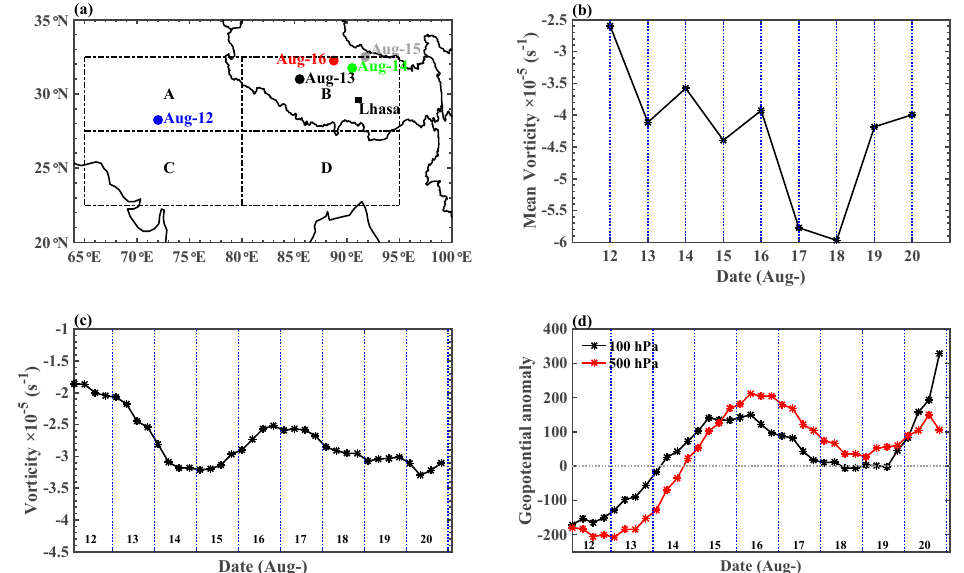
Figure 3. ( a ) The geographic locations of the ASMA centers from 12–16 August 2018. A-area (27.5–32.5 ◦ N, 65–80 ◦ E), B-area (27.5–32.5 ◦ N, 80–95 ◦ E), C-area (22.5–27.5 ◦ N, 65–80 ◦ E), and D-area (22.5–27.5 ◦ N, 80–95 ◦ E) were divided to identify the ASMA center (the black square represents the geographic location of Lhasa; the same symbols are used below); ( b ) the mean vorticity of 20 × 20 grids with the ASMA center considered as the geometric center, representing the strength of the ASMA; ( c ) the vorticity at 200 hPa over Lhasa from 12–20 August 2018; and ( d ) the geopotential height anomalies at 500 hPa and 100 hPa over Lhasa from 12–20 August